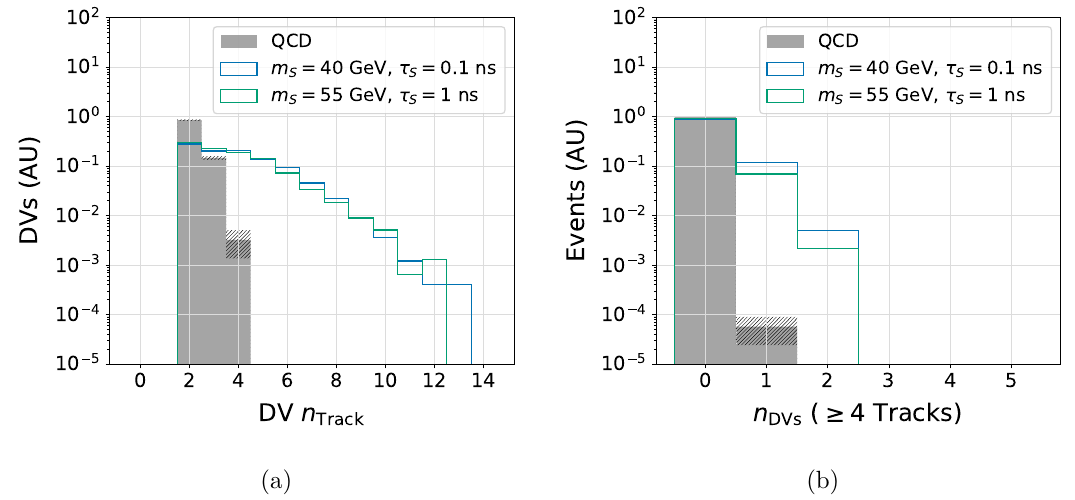
Figure 26. The number of tracks per displaced vertex (a) and the number of vertices with at least four tracks (b) per event for minimum bias QCD and representative Higgs portal signals with pile-up 200. Slashed bands on the QCD distribution represent the statistical